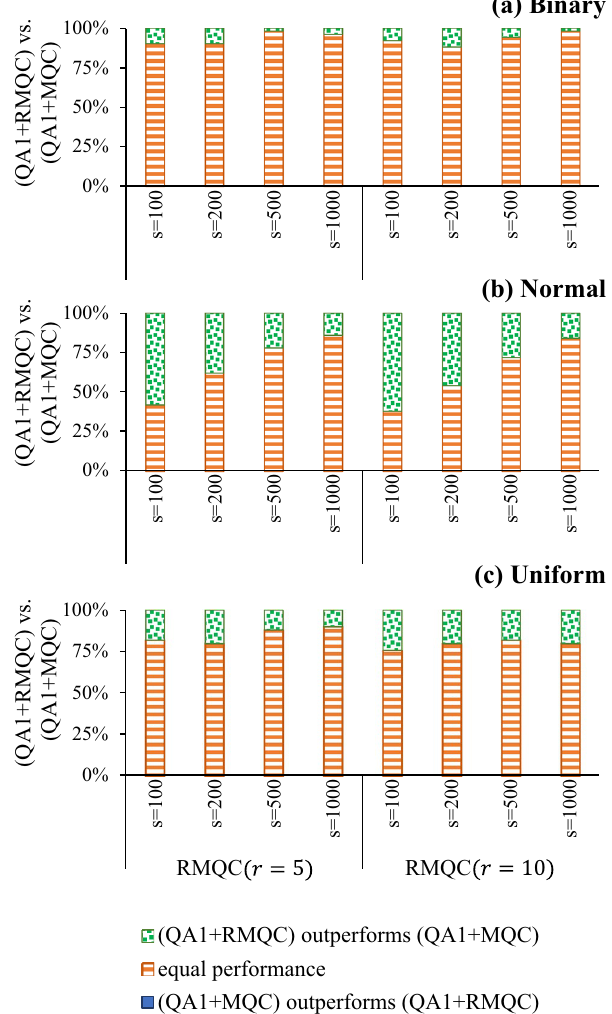
Figure 5. Performance comparison between MQC (denoted by QA 1 + MQC ) and RMQC with r = 5 and 10, denoted by QA 1 + RMQC ( s represents the number of